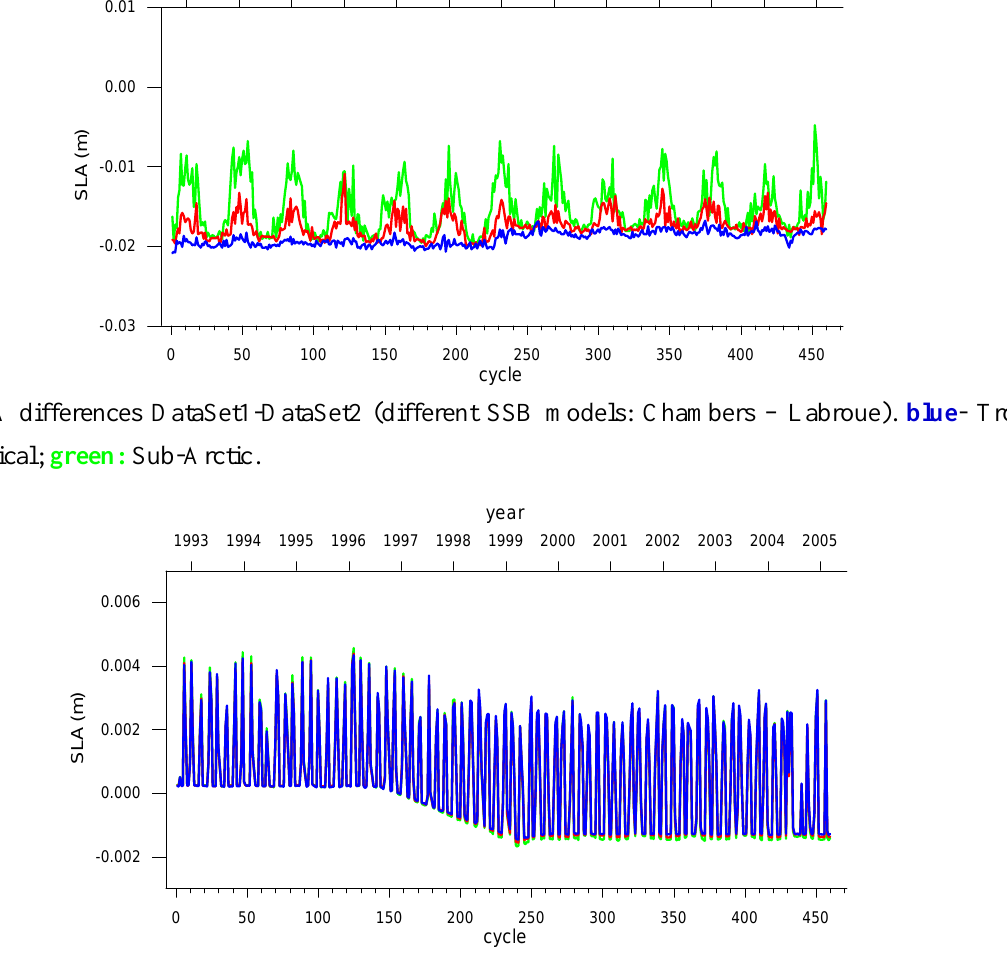
Figure 4. SLA differences for the Tropical region. blue - DataSet1- DataSet2; red - DataSet1- DataSet3; grey - DataSet1- DataSet5; yyyeeellllllooowww - DataSet1- DataSet7; light blue –DataSet5- DataSet4.